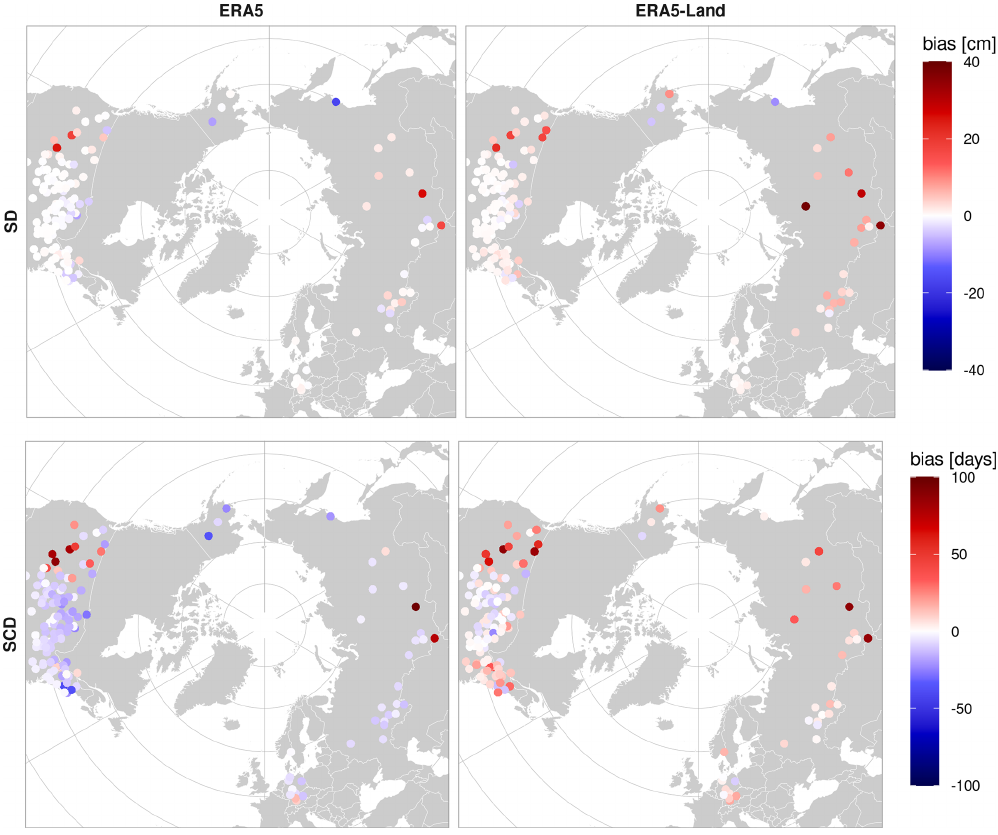
Figure 9. Bias (product – station) in snow depth (SD) and snow cover duration (SCD) after the last ERA5 discontinuity (2005–2020). Stations assimilated by ERA5 have been